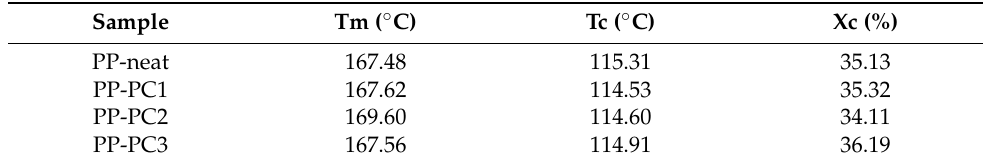
Table 2. Thermal parameters of